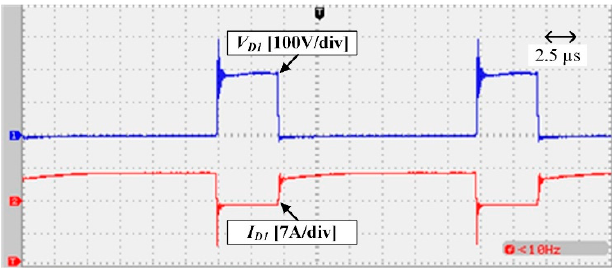
Figure 12. Voltage and current waveform of the diode D 1 .